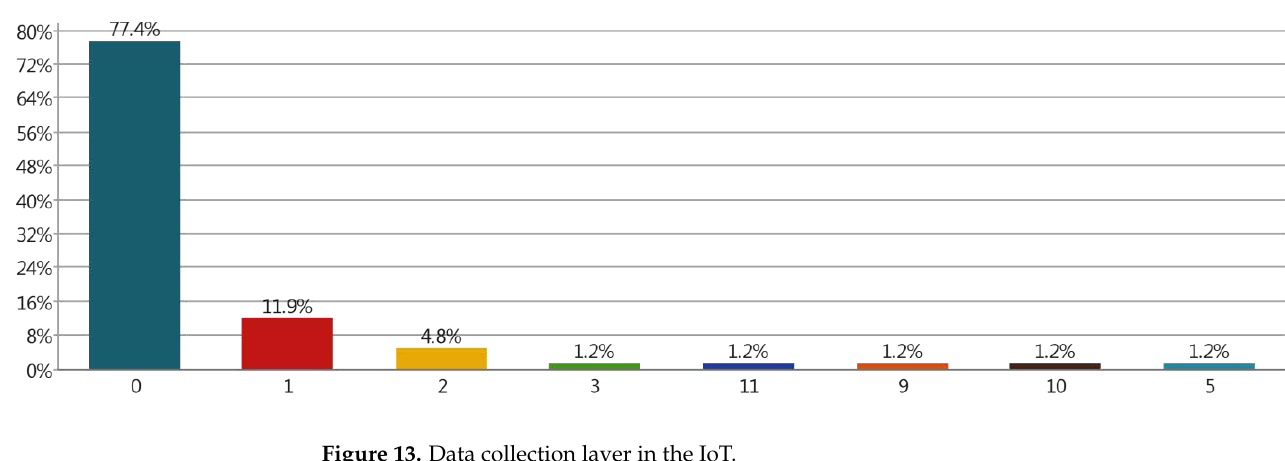
Figure 13. Data collection layer in the IoT.